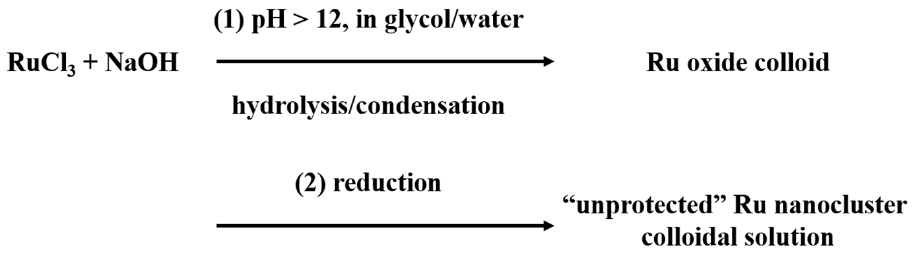
Figure 6. Procedure of the alkaline EG method for the preparation of unprotected Ru nanoclusters.